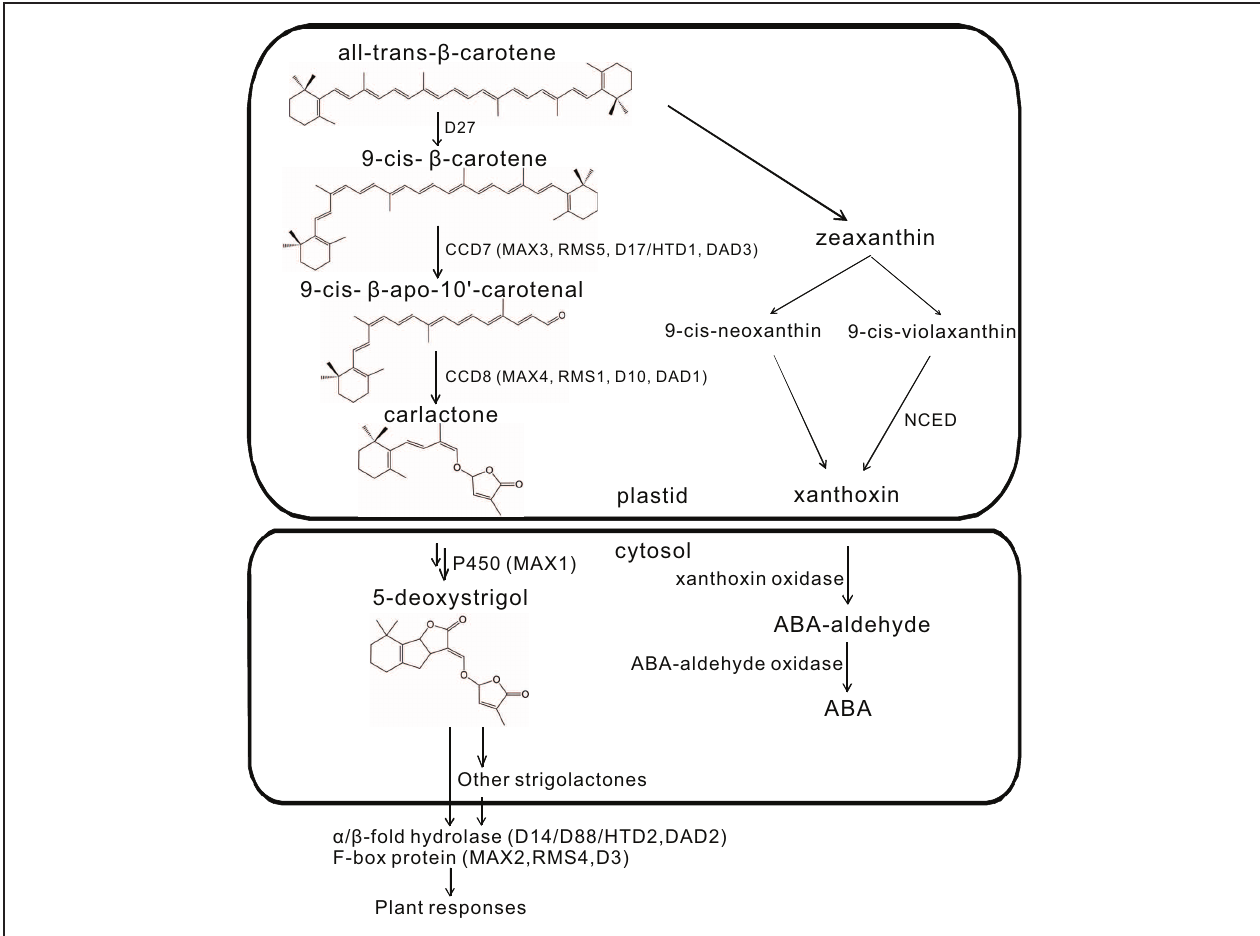
FIGURE 1 | Strigolactone and ABA biosynthetic pathways share a common origin at β -carotene. Adapted and modified from Ruyter-Spira et al. (2013).